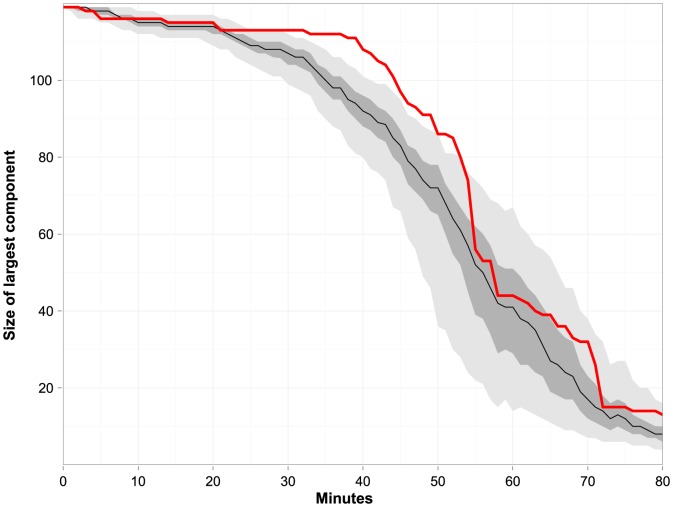
Size of the largest connected component: sub-network of non-vaccinated individuals.The figure is based on the cumulative network of all three data collection days. The red line shows the empirical size of the largest component for a minimum contact duration in minutes. The black line shows the median size of the largest component for identical contact networks with random vaccination patterns for a minimum contact duration; the dark gray area covers the range from the first to the third quartile. The light gray area covers the range from the 2.5 to the 97.5 percentile.